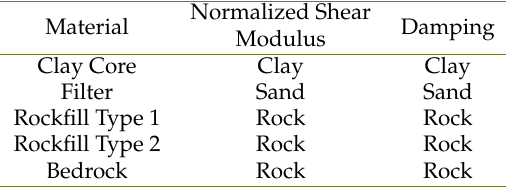
Fig. 5. Location of the Upstream and Downstream